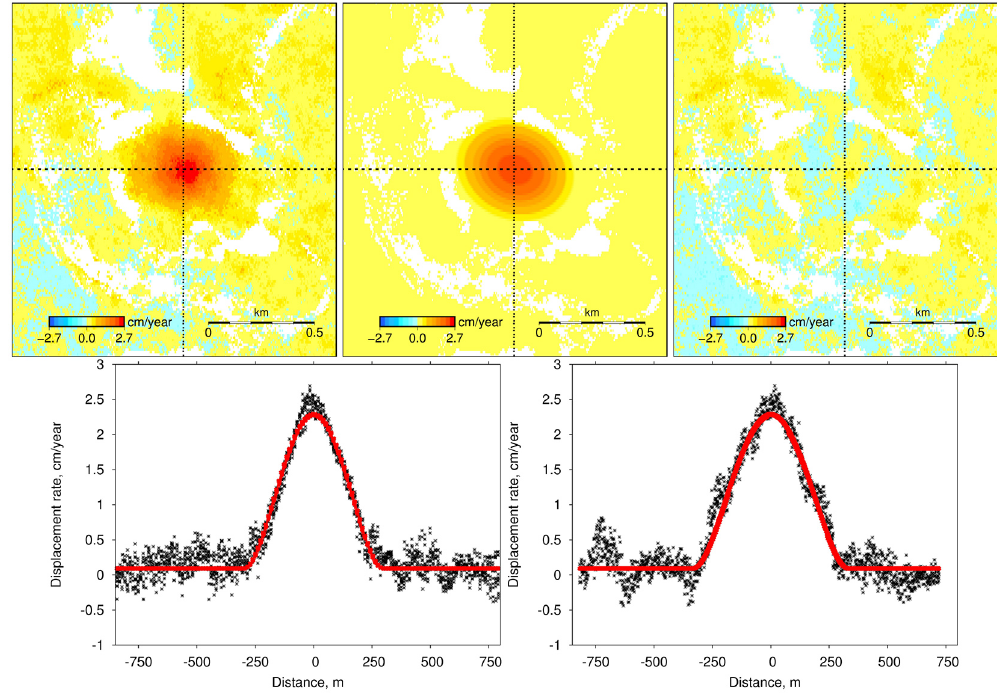
Figure 8. (Top) Observed data, model, and residual of vertical linear deformation rate. Decorrelated areas are shown in white. Best-fit model corresponds to ellipse located at 69.3728 ◦ N, 133.1688 ◦ W with semi-major and semi-minor radii of 348 ± 2m and 290 ± 2m, tilted = 1 . 46 ± 0 . 02 × 10 − 10 m − 2 . (Bottom) Latitudinal and longitudinal profiles across uplifting area. 27 ± 3 ◦ clockwise, with a magnitude of (cid:49)q D Observed data are plotted in black; modeled data are plotted in